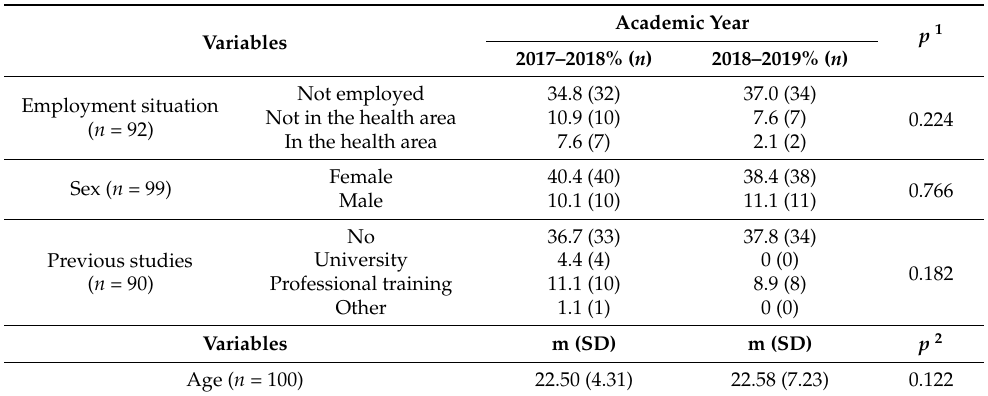
Table 1. Sociodemographic variables according to academic year ( N = 100).